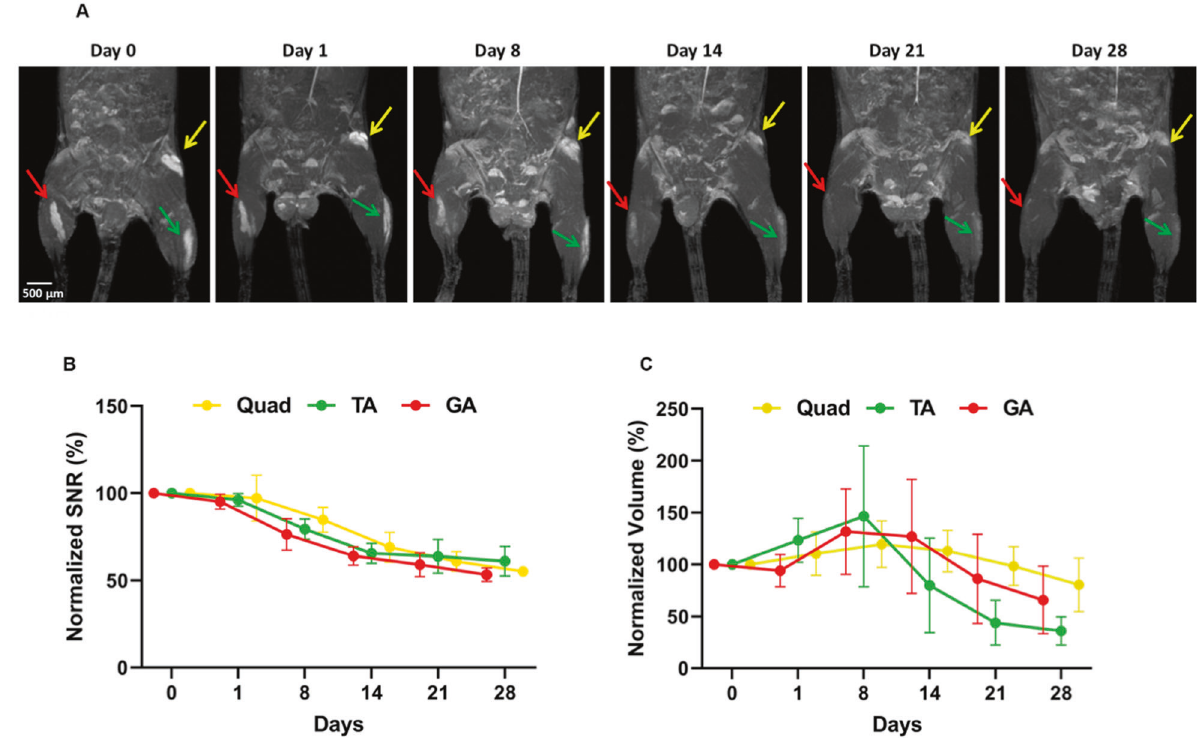
Fig. 3 In vivo biodegradation of PF microspheres. The TA, GA, and quadricep muscles were injected with 30 µl each of Gd-PF microspheres and imaged using MRI for up to 28 days. A 3D MRI reconstructions of C57-WT mice injected with Gd labeled PF microspheres. Arrows show the location of the implant injected in each muscle group - GA in red, TA in green, and Quadriceps in yellow. B Graphical representation of the segmentation data reveals a reduction in the transient Signal to Noise (SNR) parameter. C The normalized implant volume parameter exhibits an initial increase followed by a decrease.